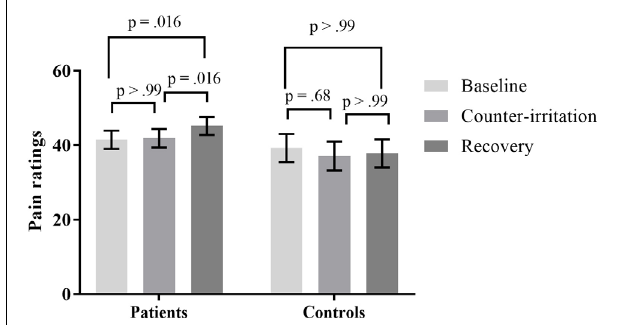
FIGURE 1 | Least square mean pain ratings for electrocutaneous stimuli for patients and controls in the baseline, counter-irritation and recovery phase. p -values are corrected for multiple testing with the stepdown Bonferroni method. Vertical bars denote standard errors.